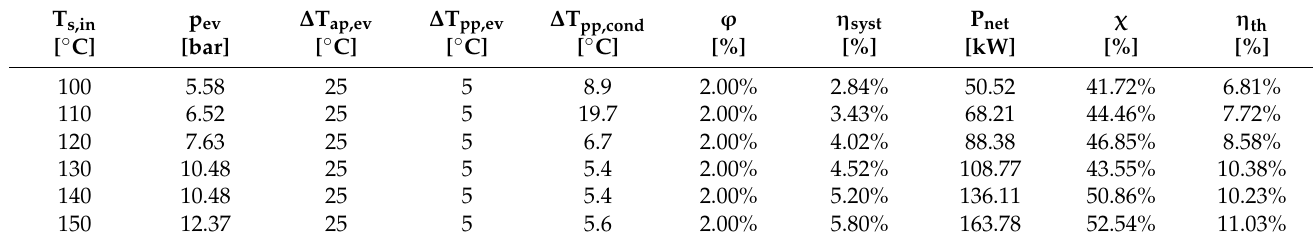
Table 1. Results of the optimization of the ORC with R245fa + MIL101 as working fluid for the considered hot source temperatures.